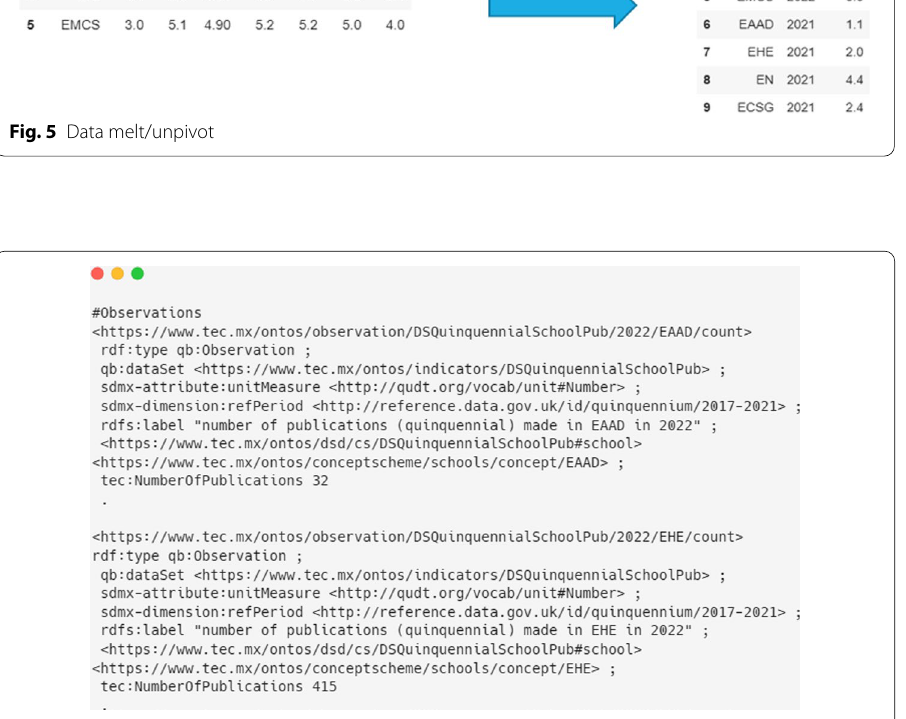
Fig. 6 Examples of indicator data points